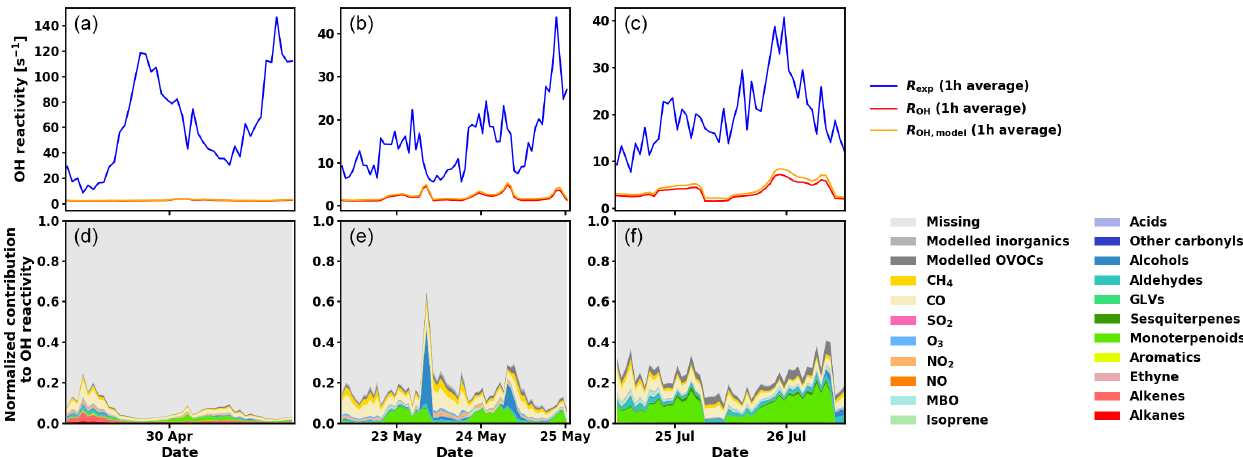
Figure 8. Measured total OH reactivity ( R exp ), calculated OH reactivity from measured compounds ( R OH ), calculated OH reactivity includ- ing measured and modelled compounds ( R OH , model ) (1h averages, a, b, c ), and normalized contributions to R exp for various compounds and groups of compounds (d, e, f) for the three periods investigated with SOSAA (see main text for